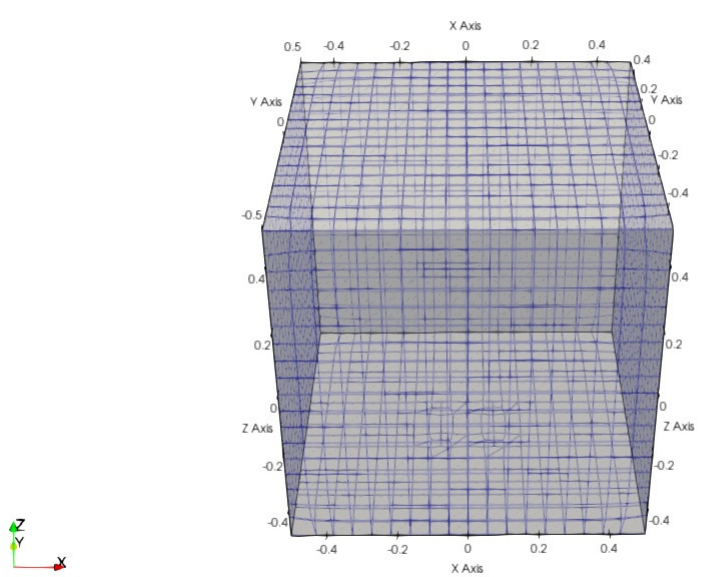
Figure 15. Model—room for experiments.